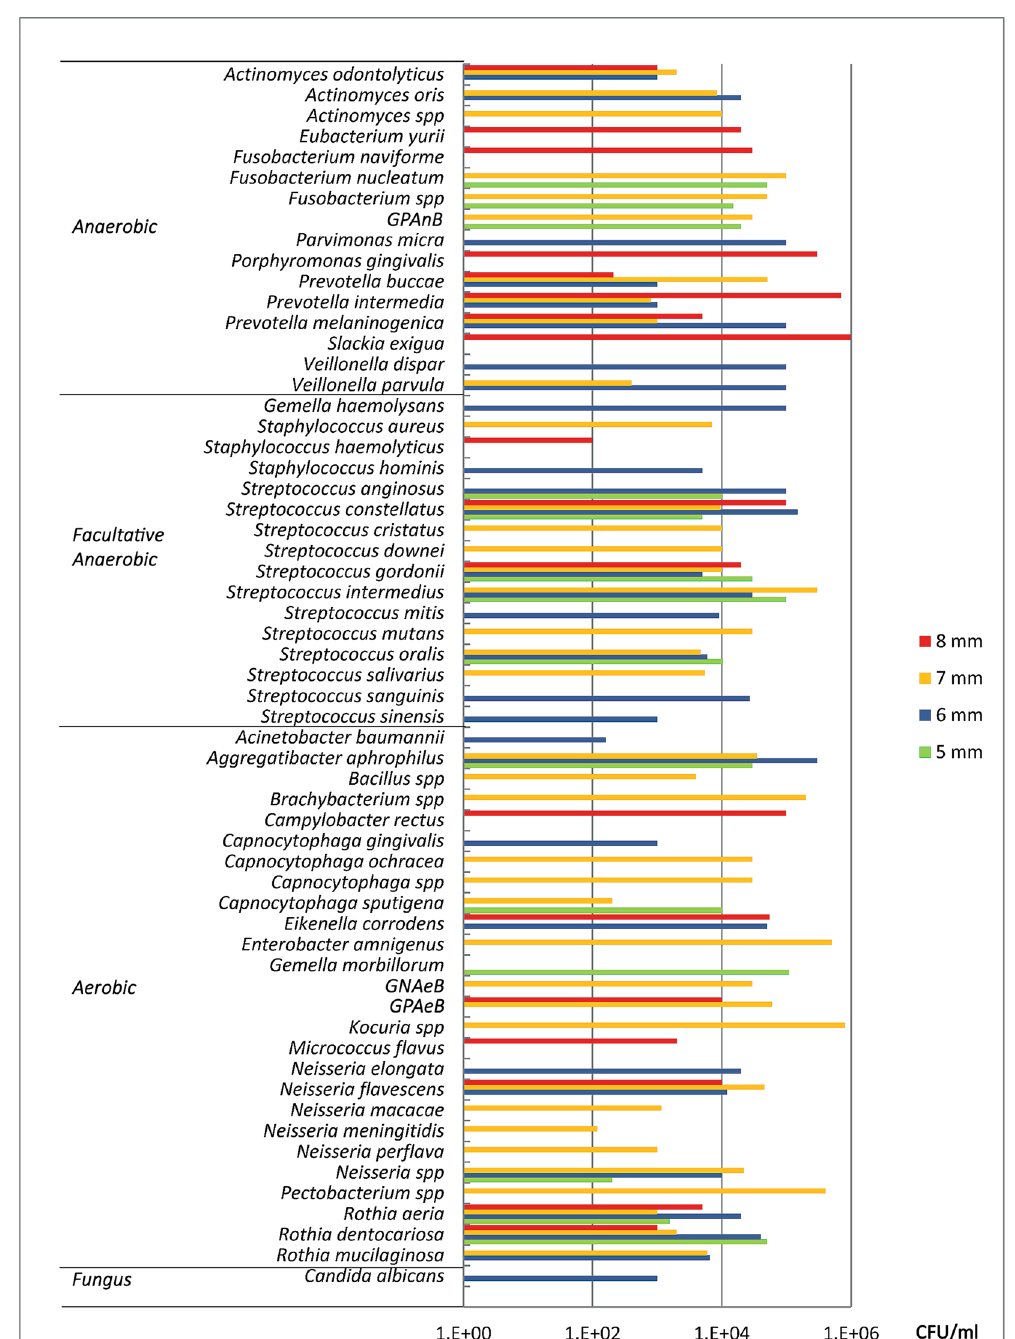
Figure 2. Median microbial counts of each strains found in different peri-implant pockets, detected by MALDI-TOF MS. Higher counts of anaerobic bacteria, such as S. exigua, P. intermedia, and P. gingivalis , were present in deeper pockets (8 mm), whereas some aerobics, such as Kocuria spp., Enterobacter amnigenus and Pectobacterium spp ., were found to be high in 7-mm PPDs. Otherwise, the distribution of facultative anaerobic and aerobic microorganisms was